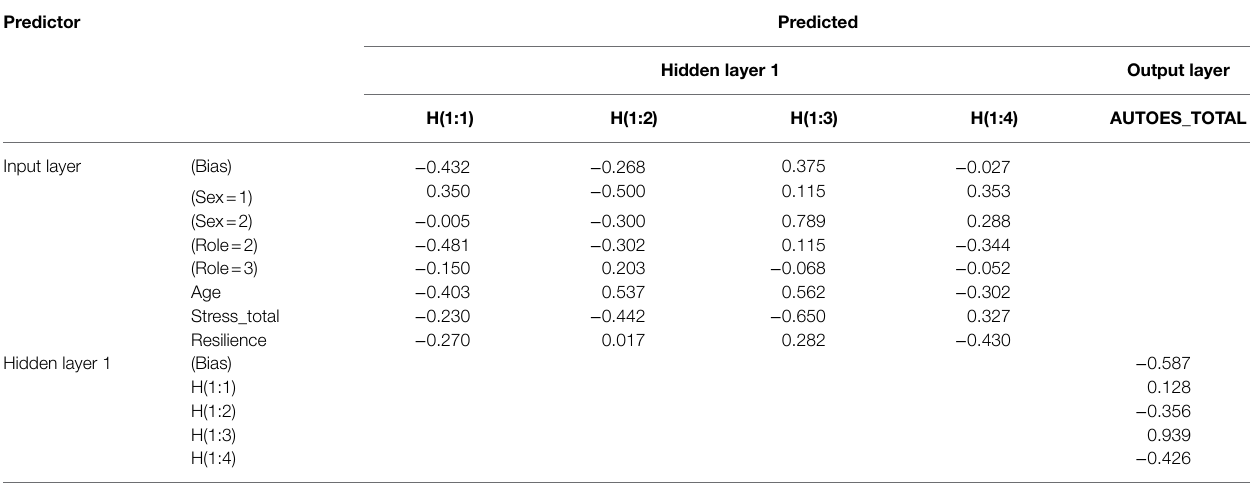
TABLE 2 | Estimated parameters of the artificial neural network. Predictor Predicted